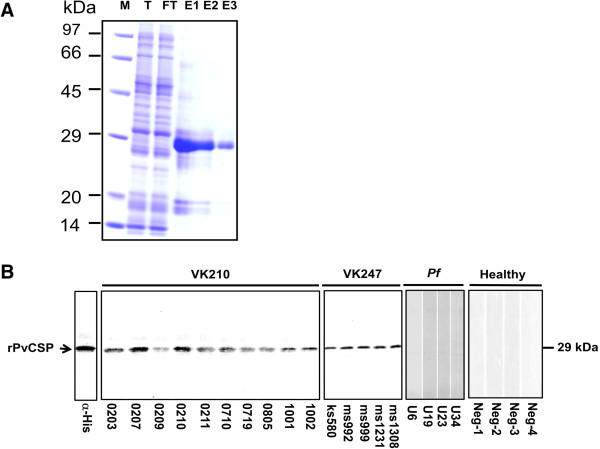
SDS-PAGE of recombinant P. vivax CSP (rPvCSP) and its immunoblot reacted with human sera. The size of the rPvCSP was 30 kDa and was estimated by comparison with known molecular weight standards (A). Purified rPvCSP was separated by SDS-PAGE under reducing condition and electroblotted onto PVDF membrane (B). The blot was blocked and reacted with Penta-His antibody, VK210 typed patient serum samples from ROK adults (numbered samples) or VK247 typed patient serum from Thailand (ks580, ms992, ms999, ms1231 and ms1308); P. falciparum infected patient serum from Uganda (U6, U19, U23 and U34) and sera from vivax naïve individuals in ROK (Neg-1, Neg-2, Neg-3 and Neg-4) as negative control. T: total translation mix; FT: flow through; E: elusion; M: molecular mass marker.